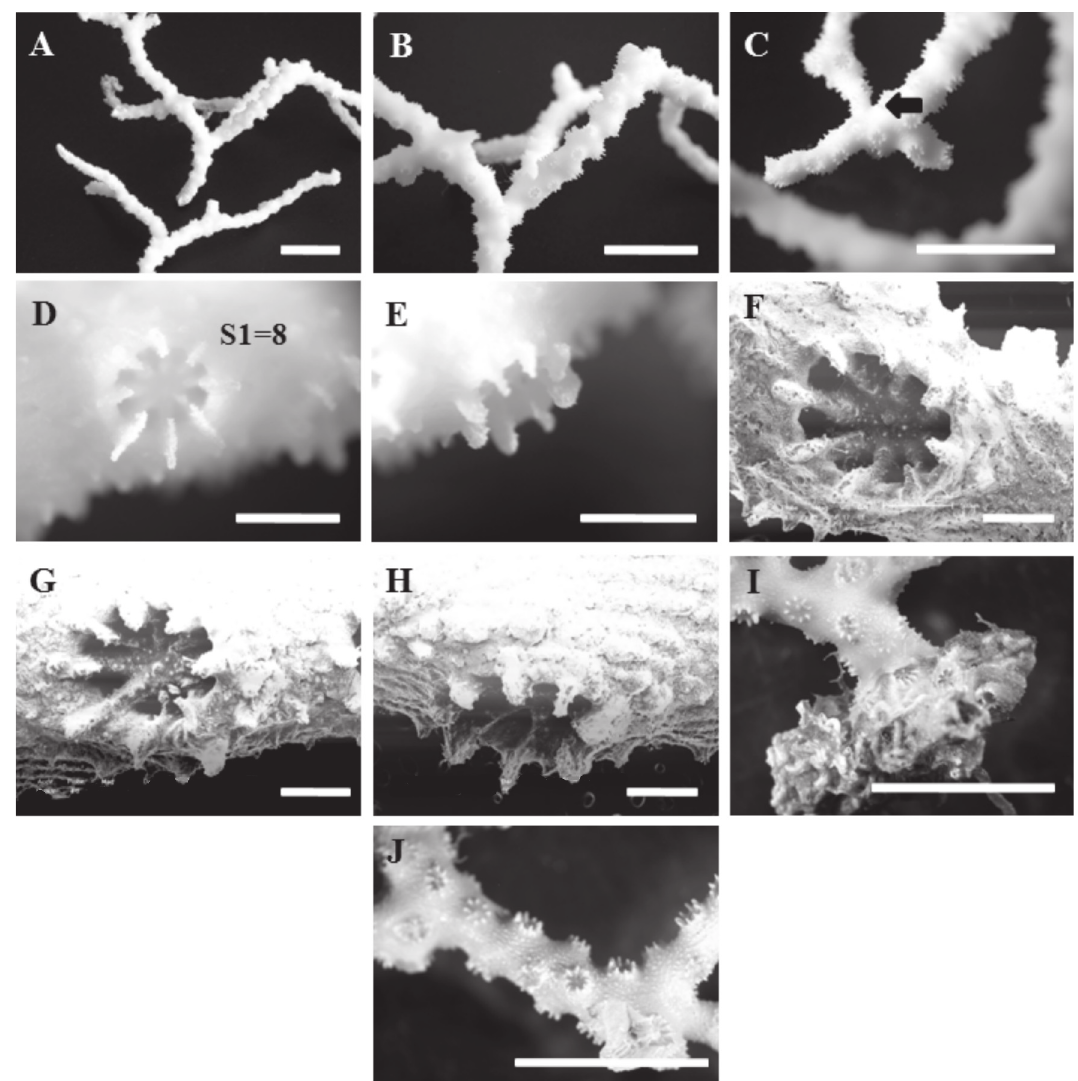
Fig . 2. – Madracis fragilis n. sp. a-h, holotype (dry specimen):a, slender branches; b, bifurcation of the primary axis; C, anastomosis in the tertiary branch; d, E, corallite uniformly circular on the branch tip with 8 primary septa (predominant arrangement); E, detail of septa project- ing upwards through the theca. F-h, sEM images of corallites: F, octameral corallite from branch tip; g, h, basal corallite: central columellar papilla and spines. i-J, paratype (fixed specimen): i. corallum base infested by tubes of serpulid worms; J, plocoid corallites regularly spaced (not crowded) along the branch. scale bars: a–C, i, J = 1.0 cm; d, E = 1.0 mm; F-h = 500 µ